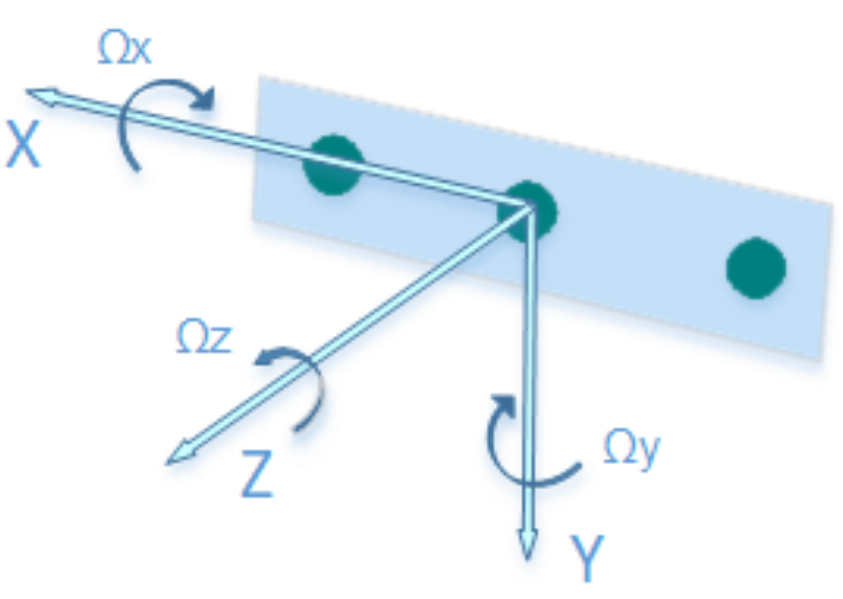
Figure 2. Intel RealSense D435i reference axes